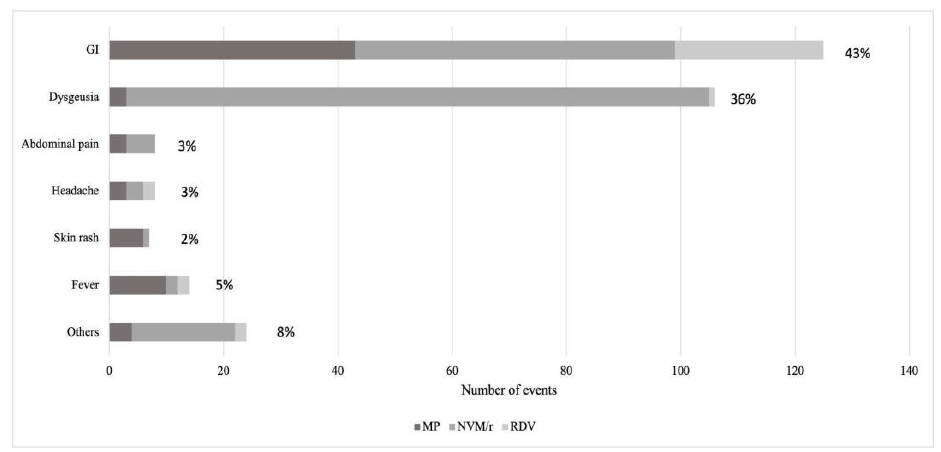
Figure 6. Adverse effects reported by patients GI: gastrointestinal. MP: molnupiravir, NMV/r: nirmatrelvir/r, RDV: remdesivir.